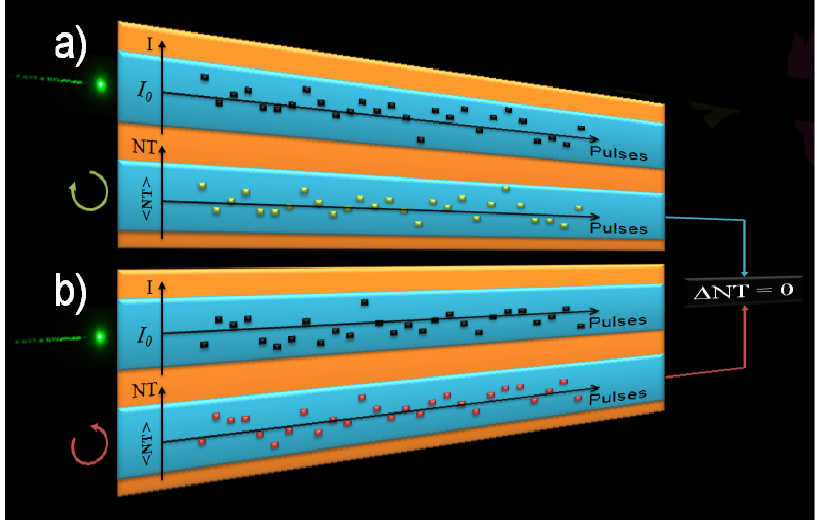
Figure 3. Representation of TPA measurements performed with the single beam Z-scan technique. (a) corresponds to measurements performed using RCPL and (b) LCPL. Top drawing represents the intensity (I) of the individual pulses exciting the sample and the bottom drawing represents the normalized transmittance (NT) measured trend for each individual pulse.